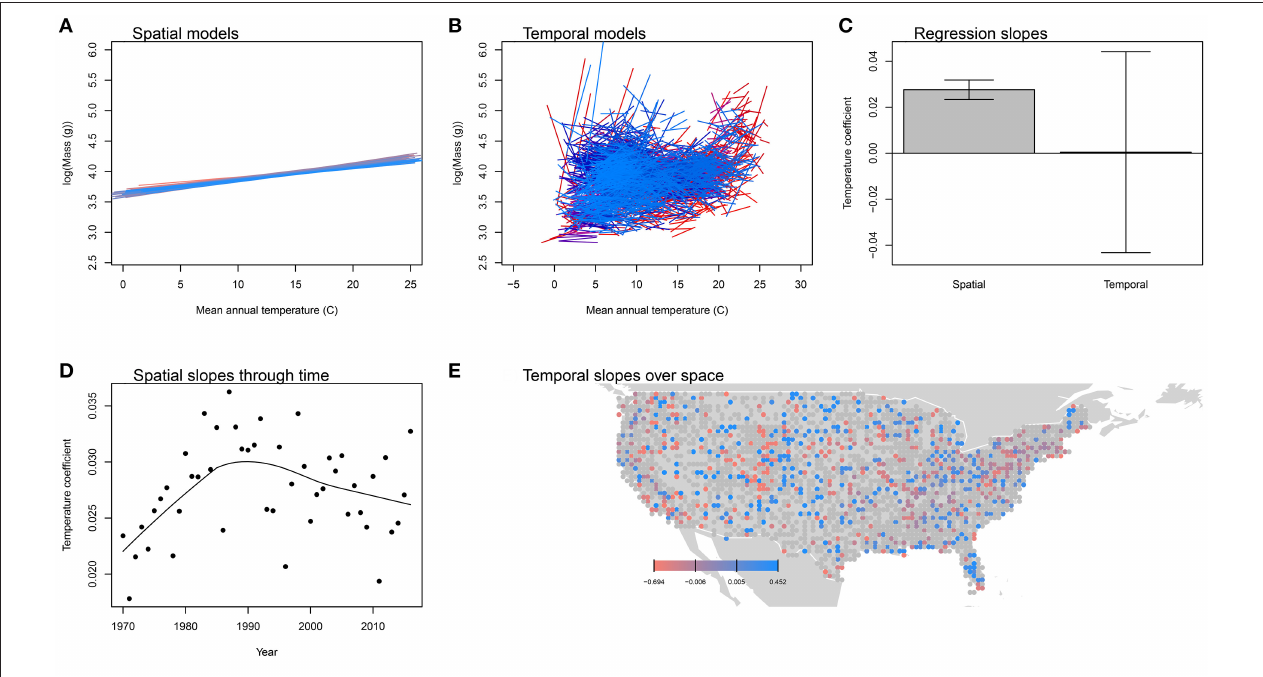
FIGURE 4 | Spatial and temporal relationships between bird body mass and temperature. (A) shows the spatial models for each year between 1970 and 2016 (earlier years are in red, later in blue). (B) shows the temporal models for each 0.5 x 0.5 degree grid cell. (C) compares the distributions of these coefficients, showing their mean and standard deviation. (D,E) show the pattern of spatial coefficients over time and temporal coefficients over space, respectively. In (D,E) , points are gray if the regression coefficients was not significant in that year or cell.